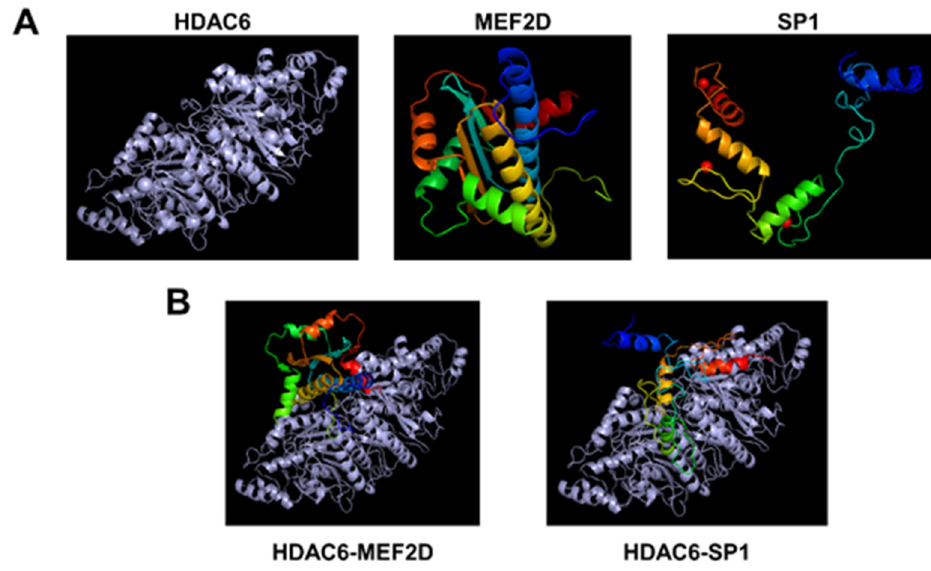
Figure 5. The molecular modeling and docking analysis for HDAC6, MEF2D, and SP1. ( A ) The 3D structure alignment of HDAC6, MEF2D, and SP1. ( B ) Molecular docking of HDAC6 with MEF2D and SP1. The gray color shows HDAC6 protein, and the rainbow shows MEF2 and SP1 proteins.